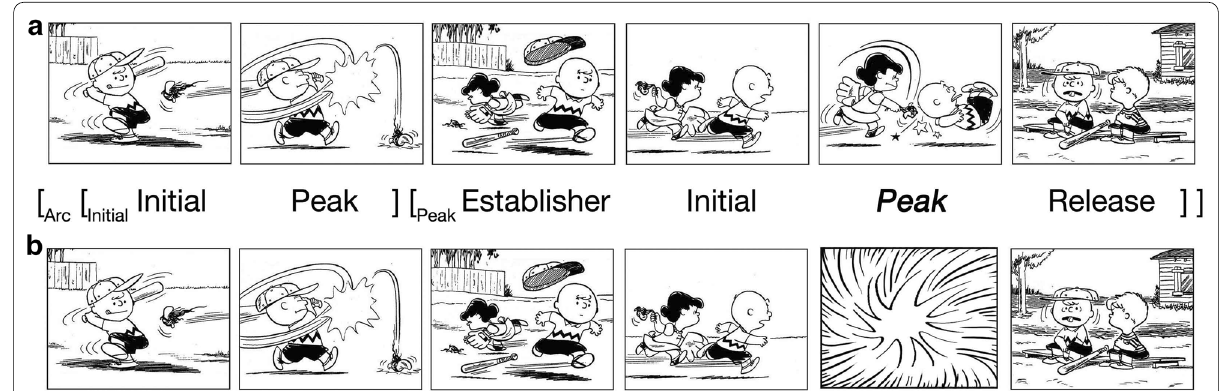
Fig. 1 Visual narrative with either an a) explicit climactic event, or its substitution by b) an action star which omits the event but still provides a narrative climax. Peanuts is © Peanuts Worldwide